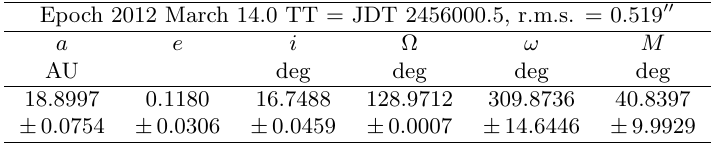
Fig. 2. The orbit of 2012 DS85 in the ecliptic plane. Positions of the asteroid and planets are presented for the date of discovery, 2012-02-19 = JD2455976.5. The dashed line denotes the part of the orbit below the ecliptic plane. Table 3. The orbit of 2012 DS85 calculated with the OrbFit software with the 1 (cid:27) errors (r.m.s.) of the